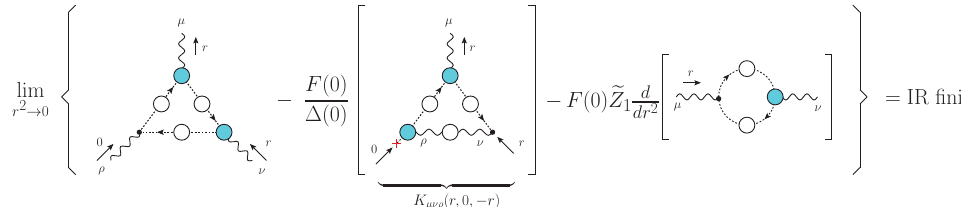
Figure 20. Diagrammatic representation of the cancellation of the infrared divergences originating from massless ghost loops in Equation (109) to yield a finite C ( 0 ) . The red cross indicates that the overall ghost momentum is factored out before being set to